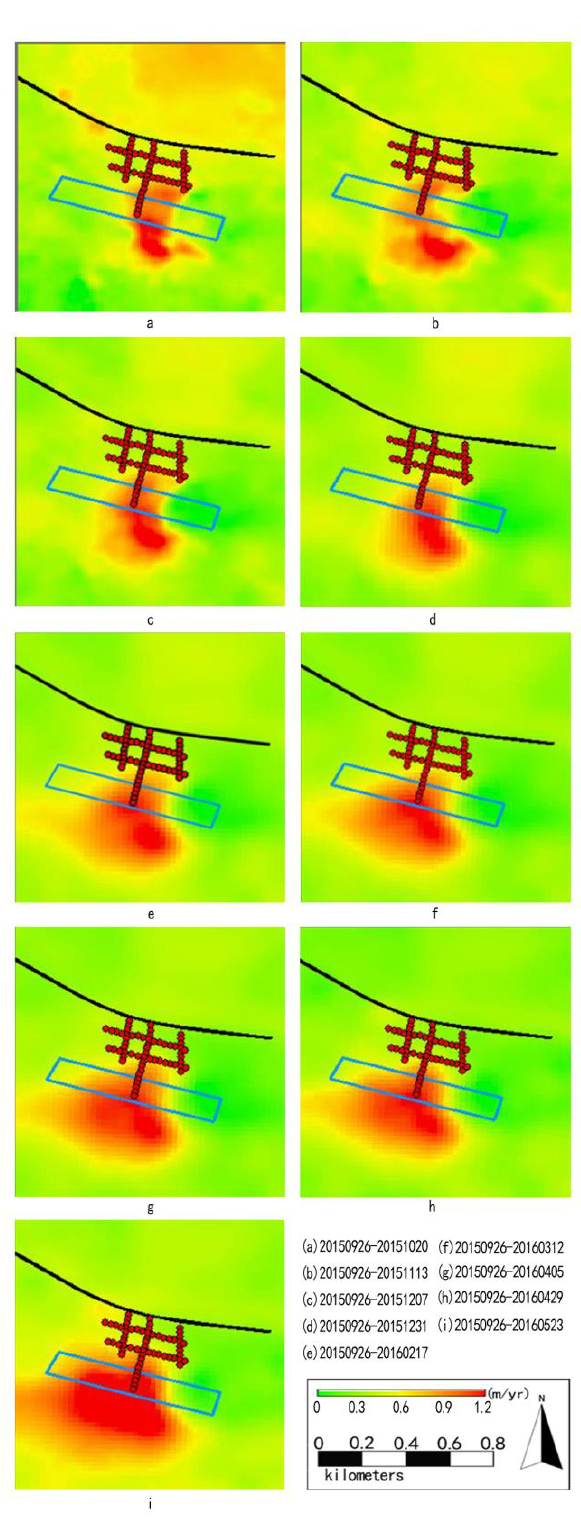
Figure 4. The accumulating subsidence DInSAR results The accumulating sequential subsidence results in Figure 2 shows that with the working face advance, the range of the subsidence area increased obviously. The results show that as the working face advance, the subsidence area extends along the south of the working face, the north of the working face is almost unaffected by the land subsidence. The railway in this study is in the north of the working face. So the InSAR